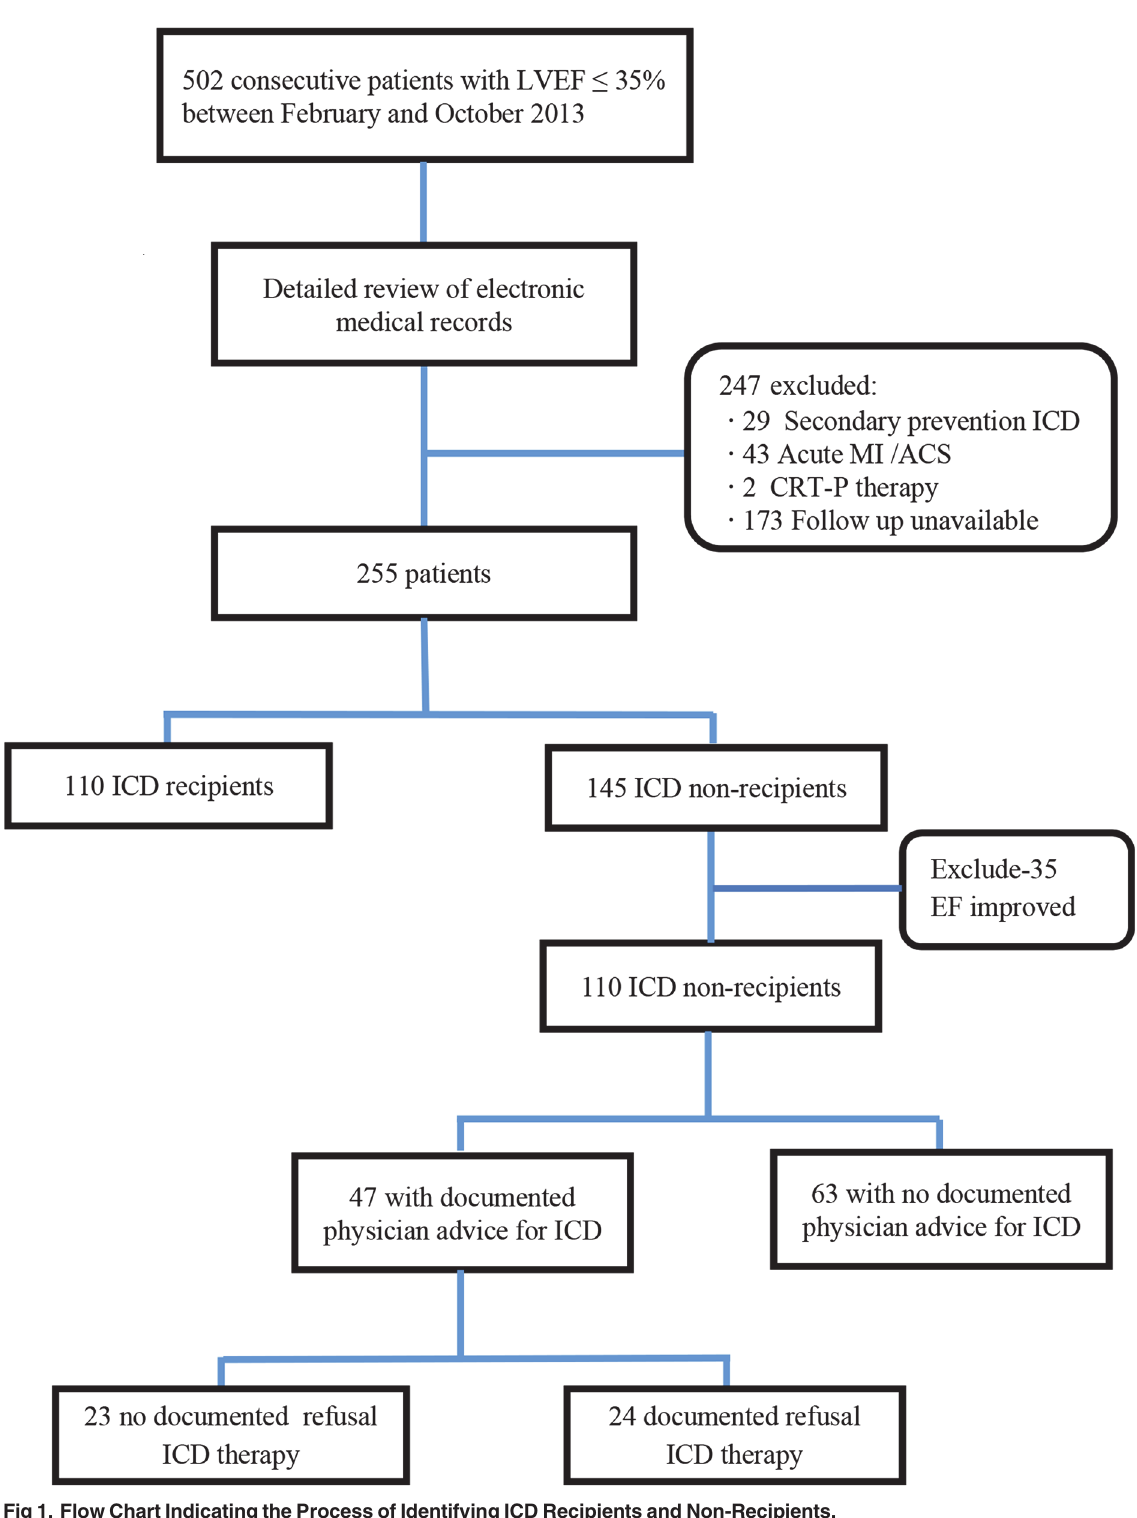
Fig 1. Flow Chart Indicating the Process of Identifying ICD Recipients and Non-Recipients.